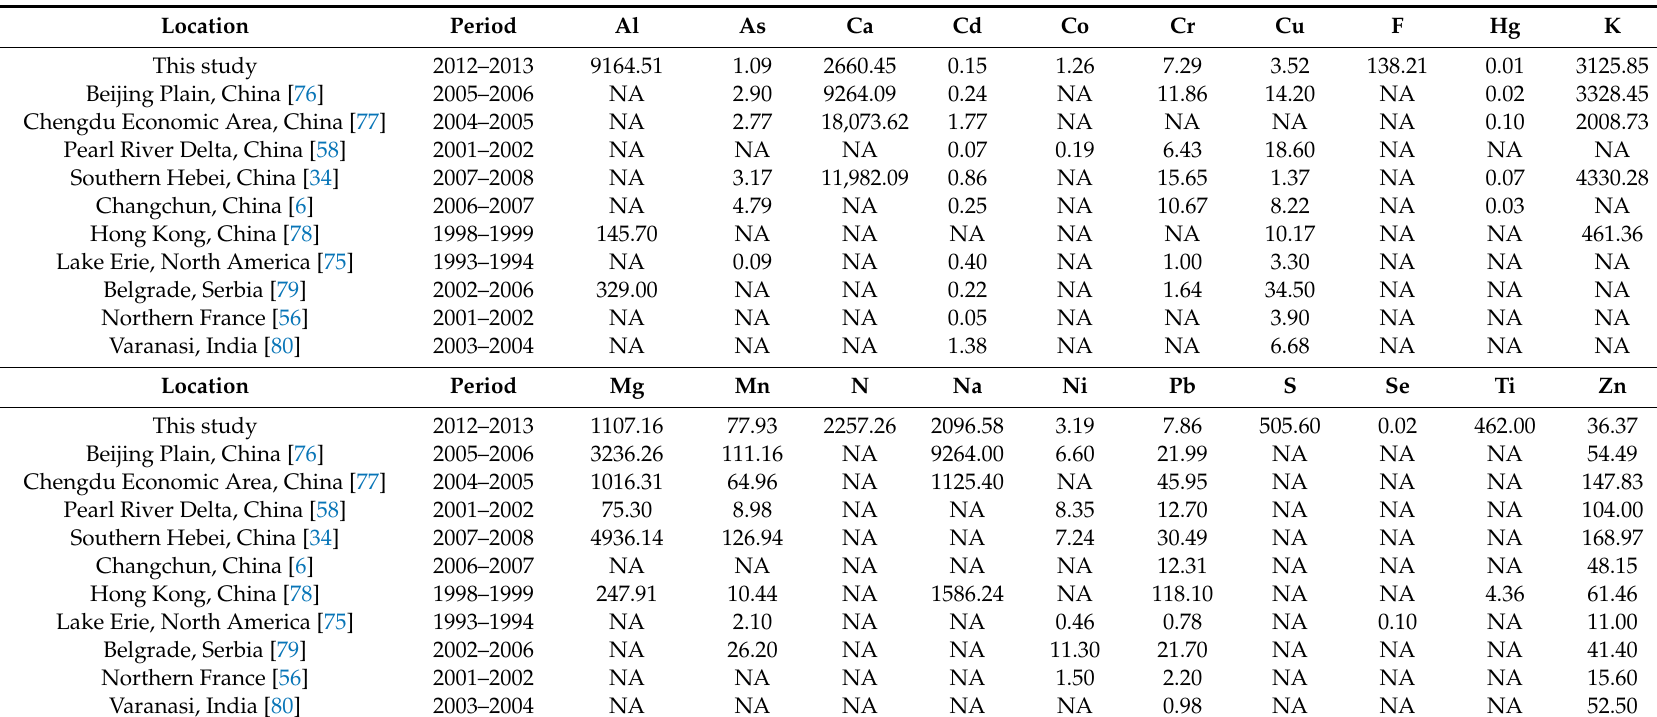
Table 3. Comparison of atmospheric deposition fluxes in Gannan County area and other areas (g · hm − 2 · a − 1